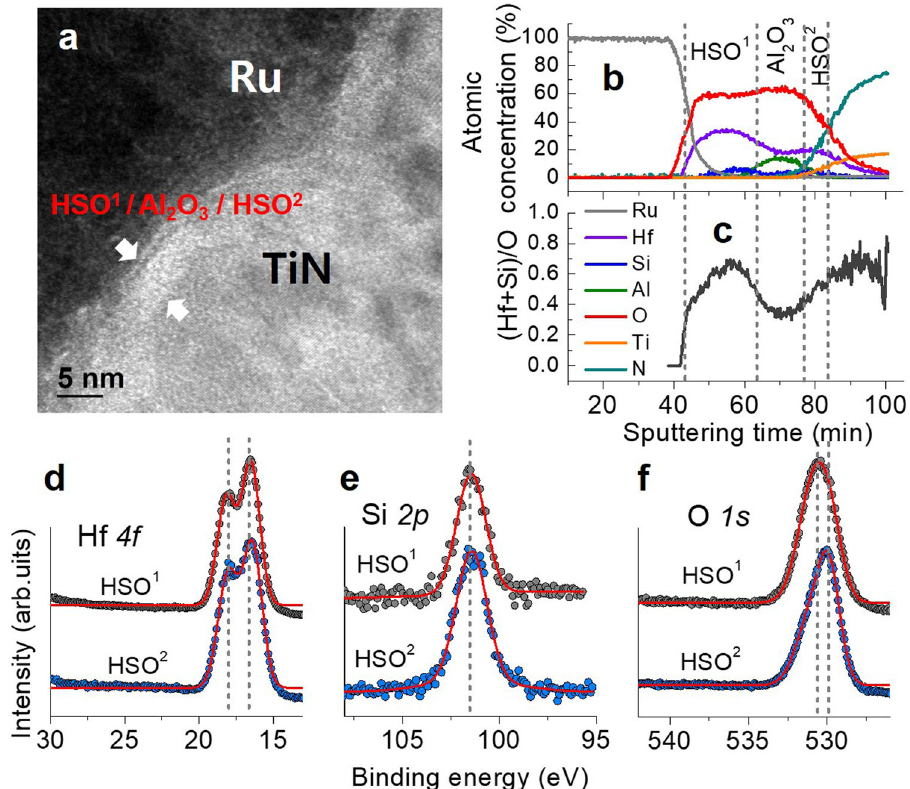
Fig. 2 Microstructural and chemical analyses. a Cross-sectional high-resolution transmission electron microscope image of our SRMC. b Depth pro fi le of the elements, which were measured by Auger electron microscopy. c Atomic ratio (Hf + Si)/O along depth of SRMC. X-ray photoelectron spectra of d Hf4 f , e Si2 p , and f O1 s emission for HSO 1 and HSO 2 .